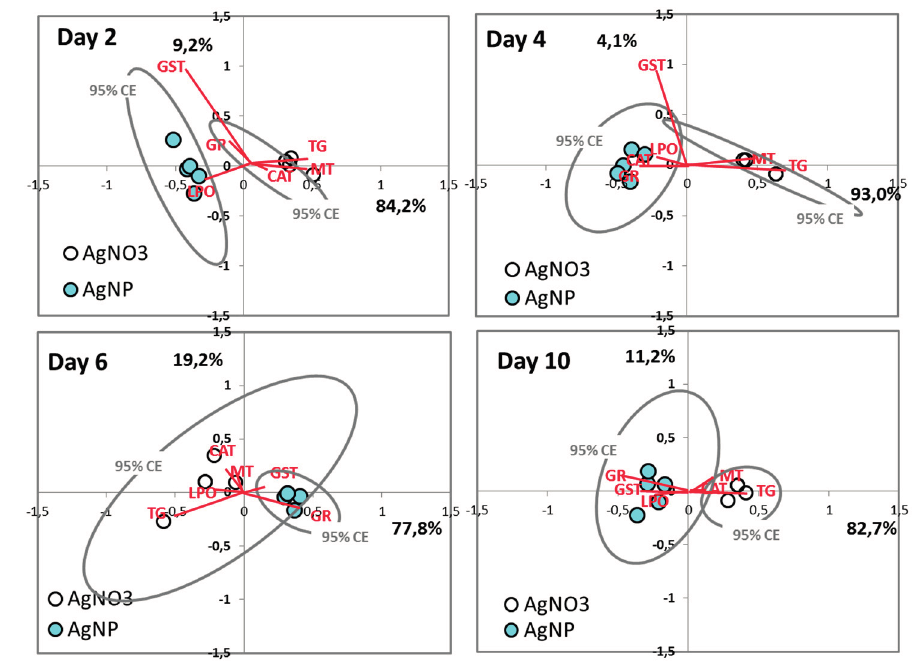
Figure 3. Correspondence Analysis (CA) of data from Folsomia candida exposed to AgNP (Ag NM300K) [640 mg Ag/kg soil] and AgNO 3 [145 mg Ag/kg soil], as sampled at 0-2-4-6-10 days, in terms of Catalase (CAT), Glutathione Peroxidase (GPx), Glutathione S-Transferase (GST), Glutathione Reductase (GR), Total Glutathione (TG),